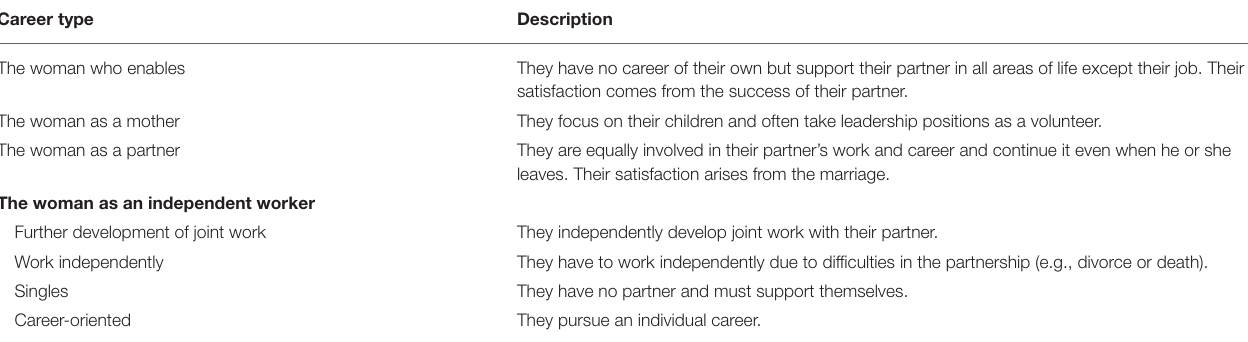
TABLE 7 | Career patterns of women according to Tomlinson-Keasey (1990). Career type